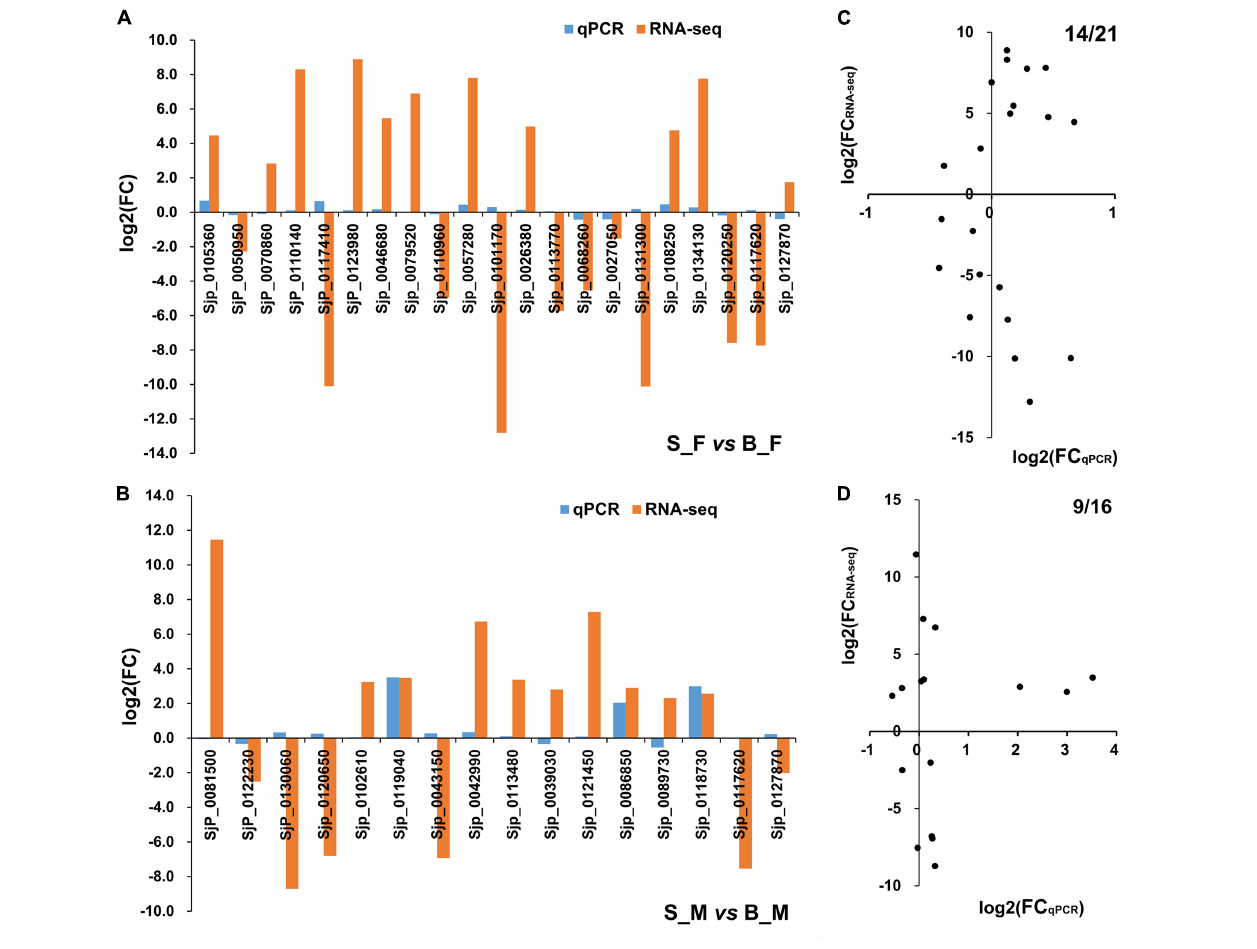
FIGURE 4 | Consistency assessment of the expression patterns of 35 selected differentially expressed genes (DEGs) between RNA sequencing (RNA-seq) and quantitative reverse transcriptase PCR (qRT-PCR) data. (A,B) Histograms of the relative expressions of the selected 21 (19 + 2) DEGs in Schistosoma japonicum between S_F vs. B_F (A) and the selected 16 (14 + 2) DEGs in S. japonicum between S_M vs. B_M (B) using RNA-seq and qRT-PCR analysis. (C,D) Scatter plots for consistency assessment of the relative expressions of the 21 (19 + 2) DEGs in S. japonicum between S_F vs. B_F (C) and the 16 (14 + 2) DEGs in S. japonicum between S_M vs. B_M (D) using RNA-seq and qRT-PCR analysis. The qRT-PCR data are presented as the mean derived from duplicate experiments; their standard deviation is shown in Supplementary Figure S2 . B_F female worms from BALB/c mice, B_M male worms from BALB/c mice, S_F female worms from SCID mice, S_M male worms from SCID